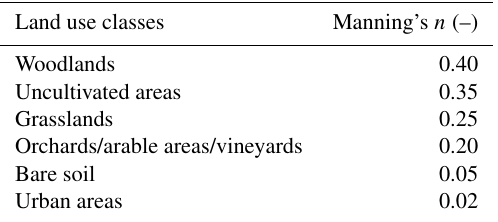
Table 1. Overland flow Manning’s n Roughness Values assigned to each class of land use maps available for the calculation of W lin